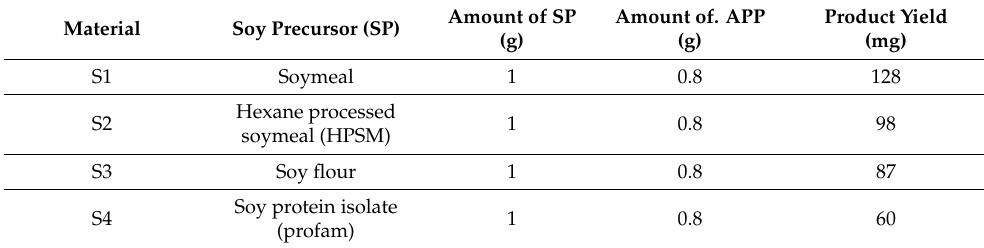
Table 1. Composition of materials